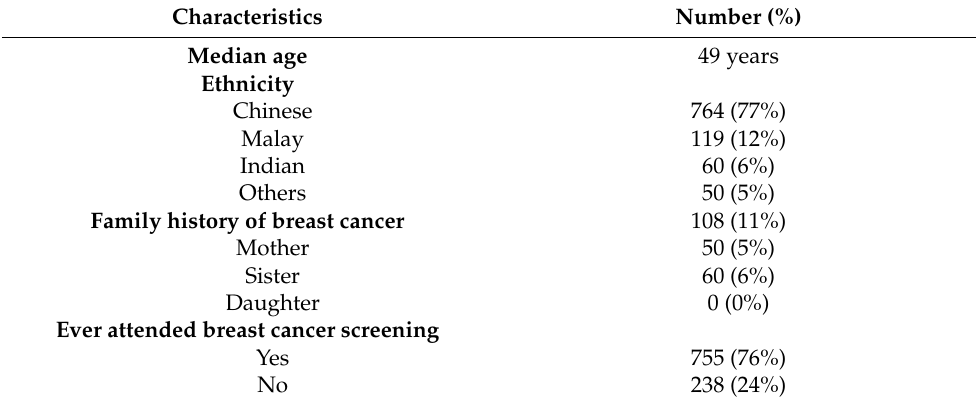
Table 2. Characteristics of 993 survey